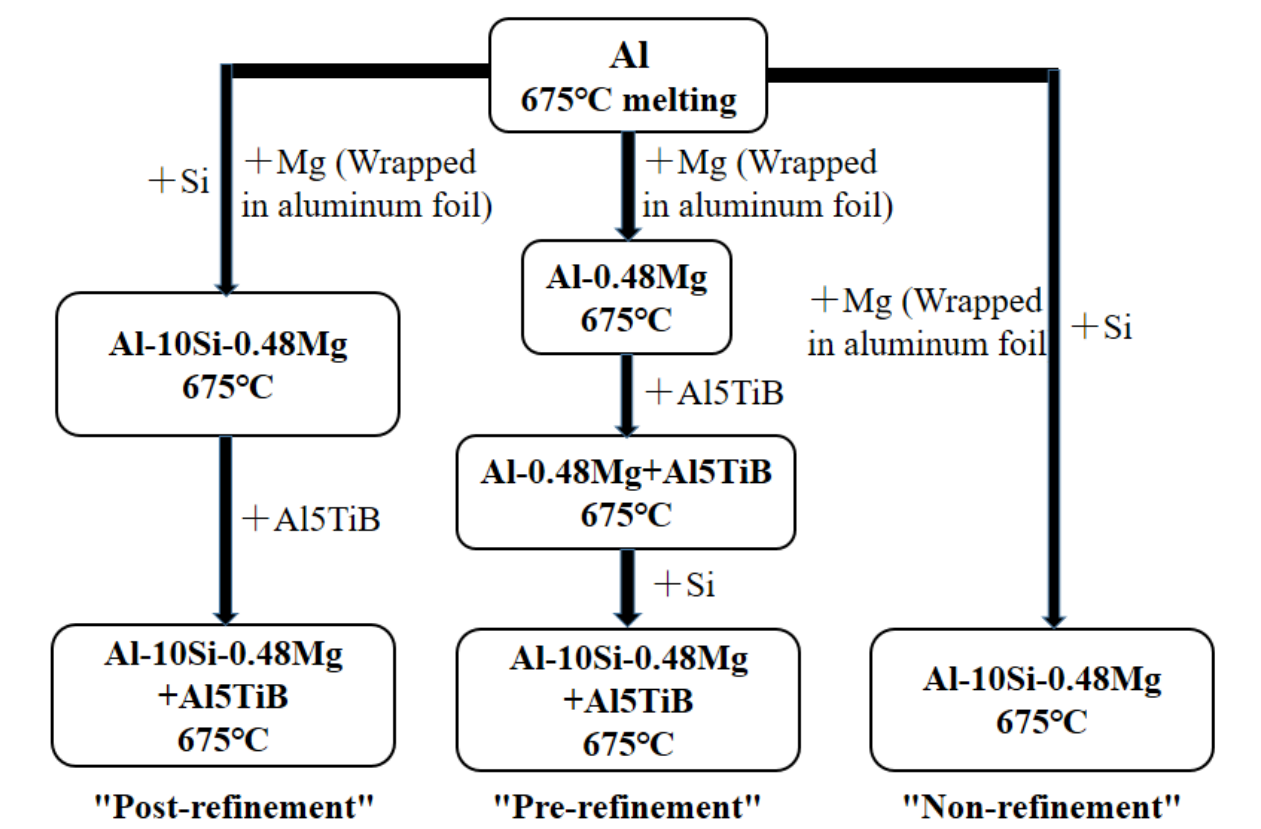
Figure 3. Schematic diagram of preparation paths of the three types of alloys: “post-refinement”, “pre-refinement”, and “non-refinement”.